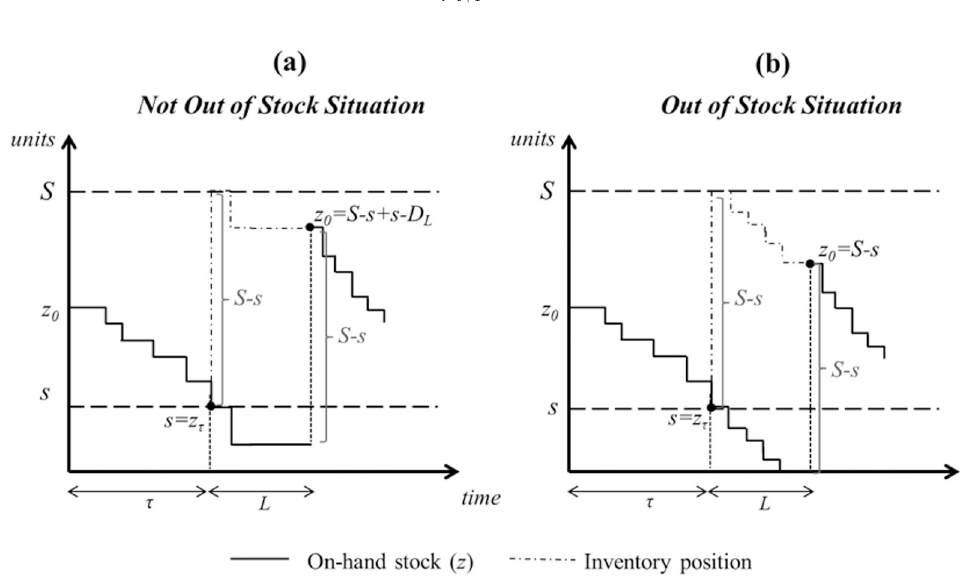
Fig 2. Evolution of the stock in a ( s , S ) inventory policy when undershoots are neglected.